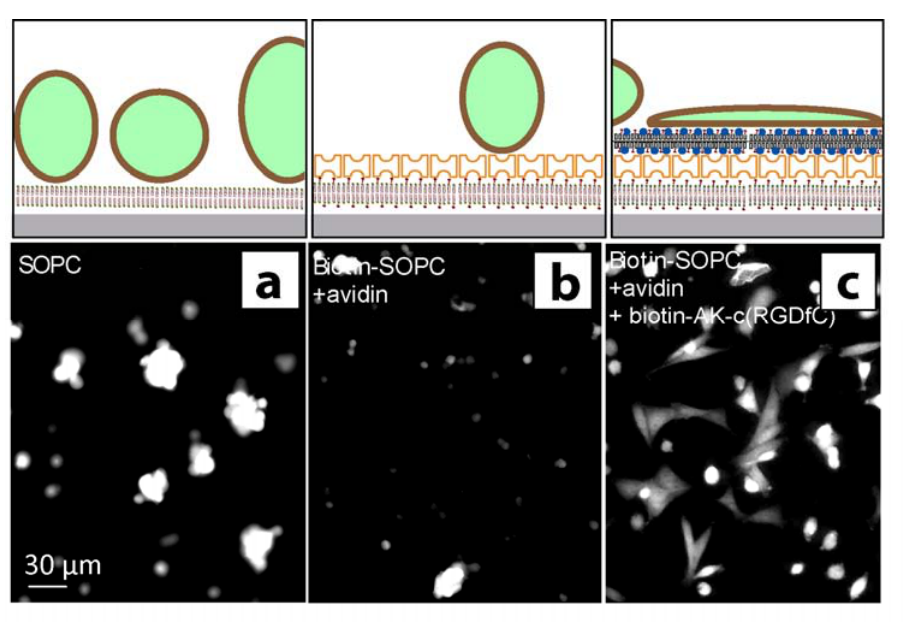
Figure 5. Fluorescence microscopy (FM) images of GFP expressing (fluorescent) radial glial cells. The FM images were recorded 4 h after cell seeding. ( a ) Radial glial cells attached to SOPC coated surfaces show a spheroid shape; ( b ) Cell attachment to an avidin functionalized biotinylated membrane is largely suppressed; ( c ) Rapid spreading of glial cells is observed for the biotin-AK-c[RGDfC] functionalized membrane. Schematics illustrate the conformation of the cells on the